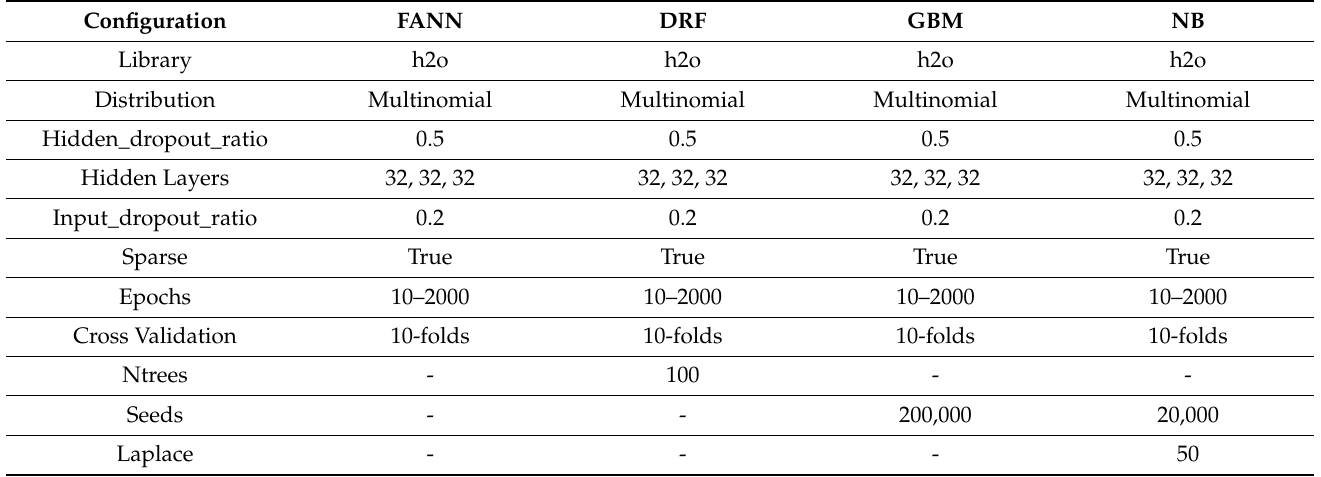
Table 6. Feedforward artificial neural network (FANN), distributed random forest (DRF), gradient boosting machine (GBM), naïve Bayes (NB) parameter